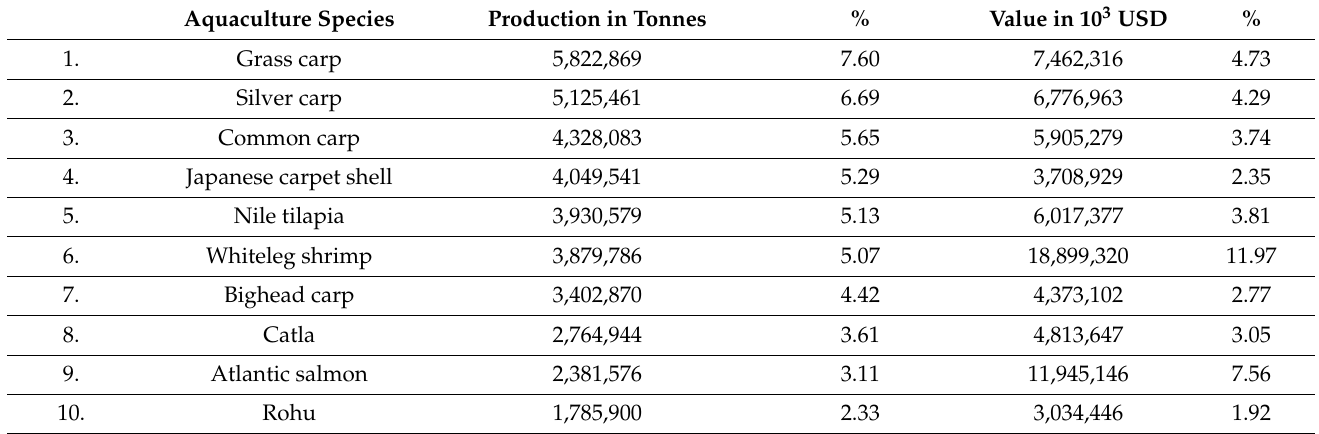
Table 3. Top 10 aquaculture species in the world.